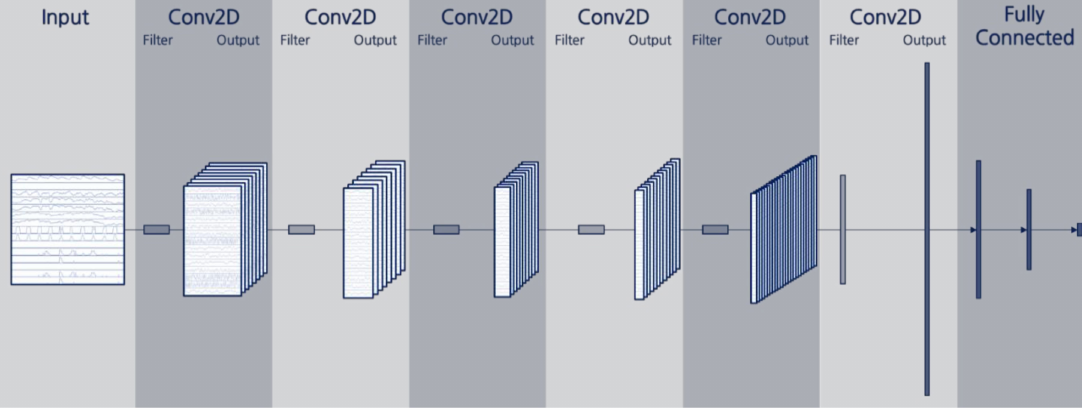
Figure 2. Model structure of convolution neural network (CNN) for temperature